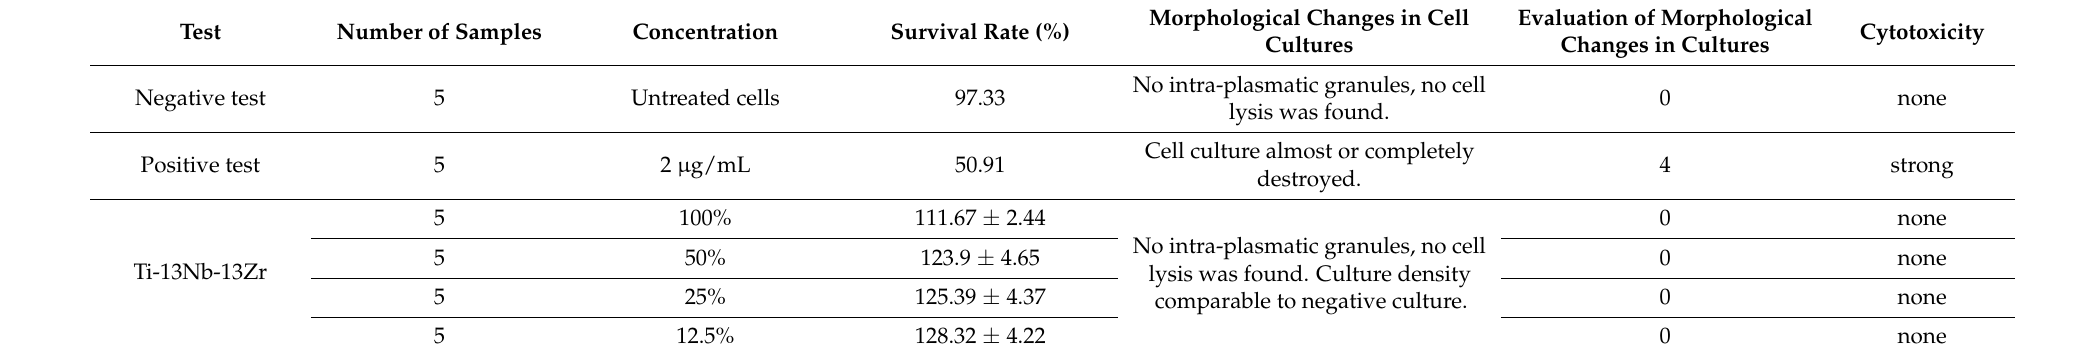
Table 6. MTT test result for MC3T3 cells.